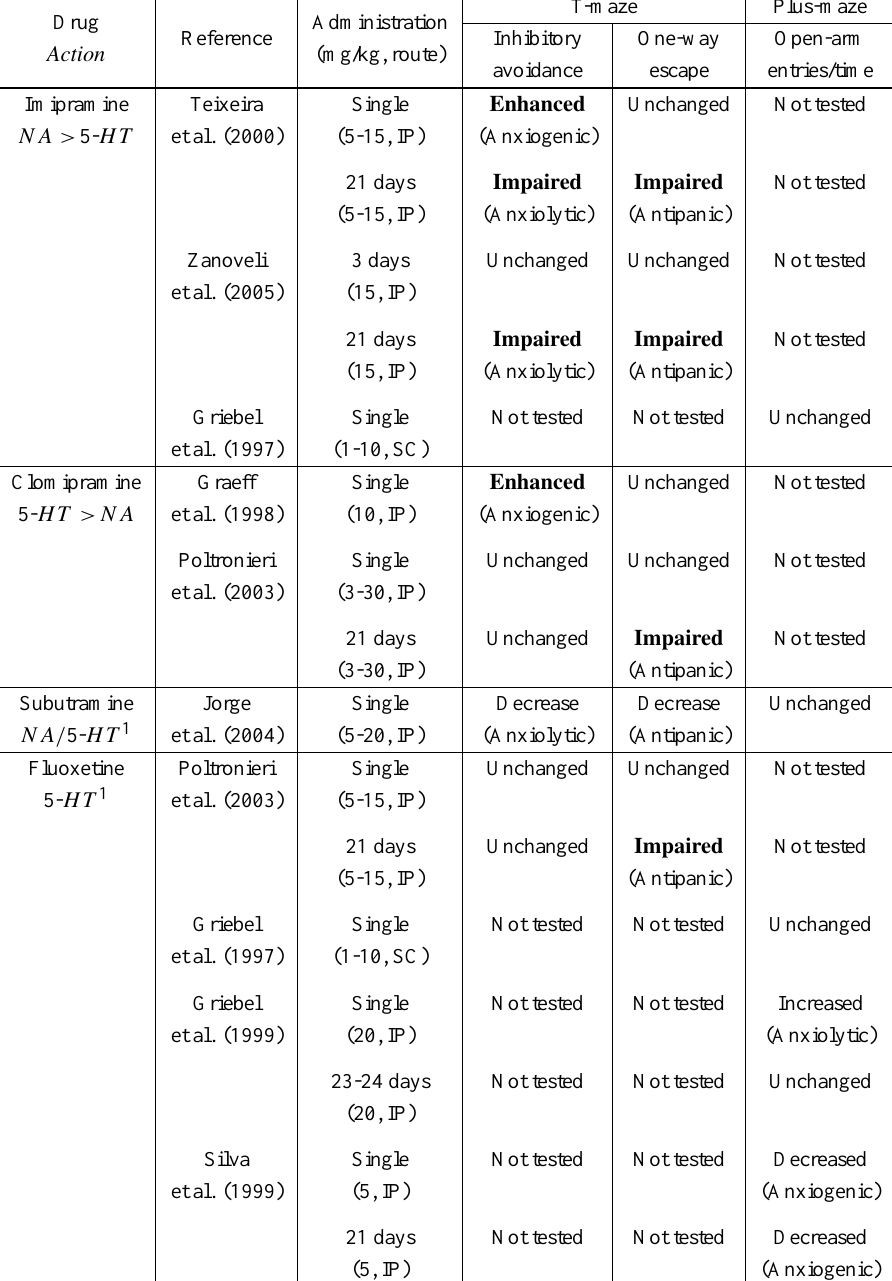
Comparative effects of reuptake inhibitors on rat behavior in two elevated